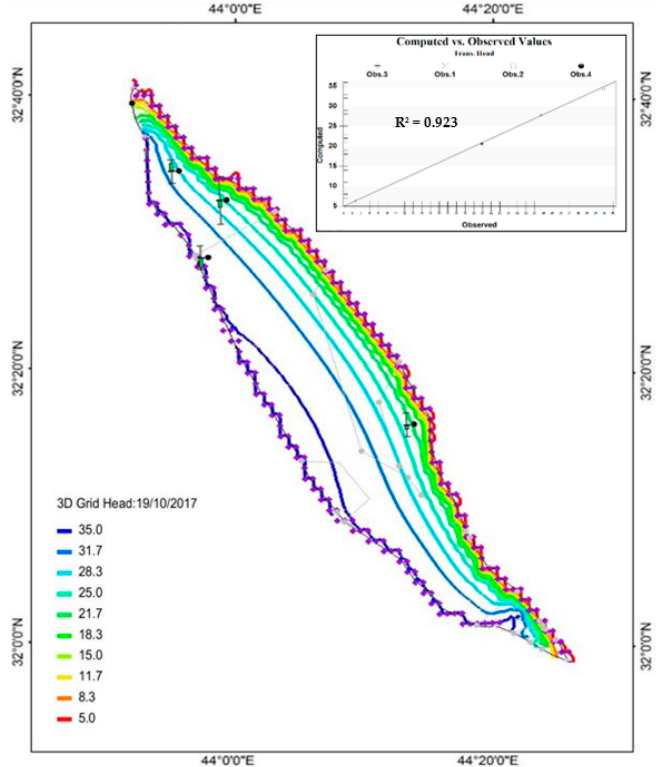
Figure 4. Calibration simulated heads of the steady area during the transient simulation